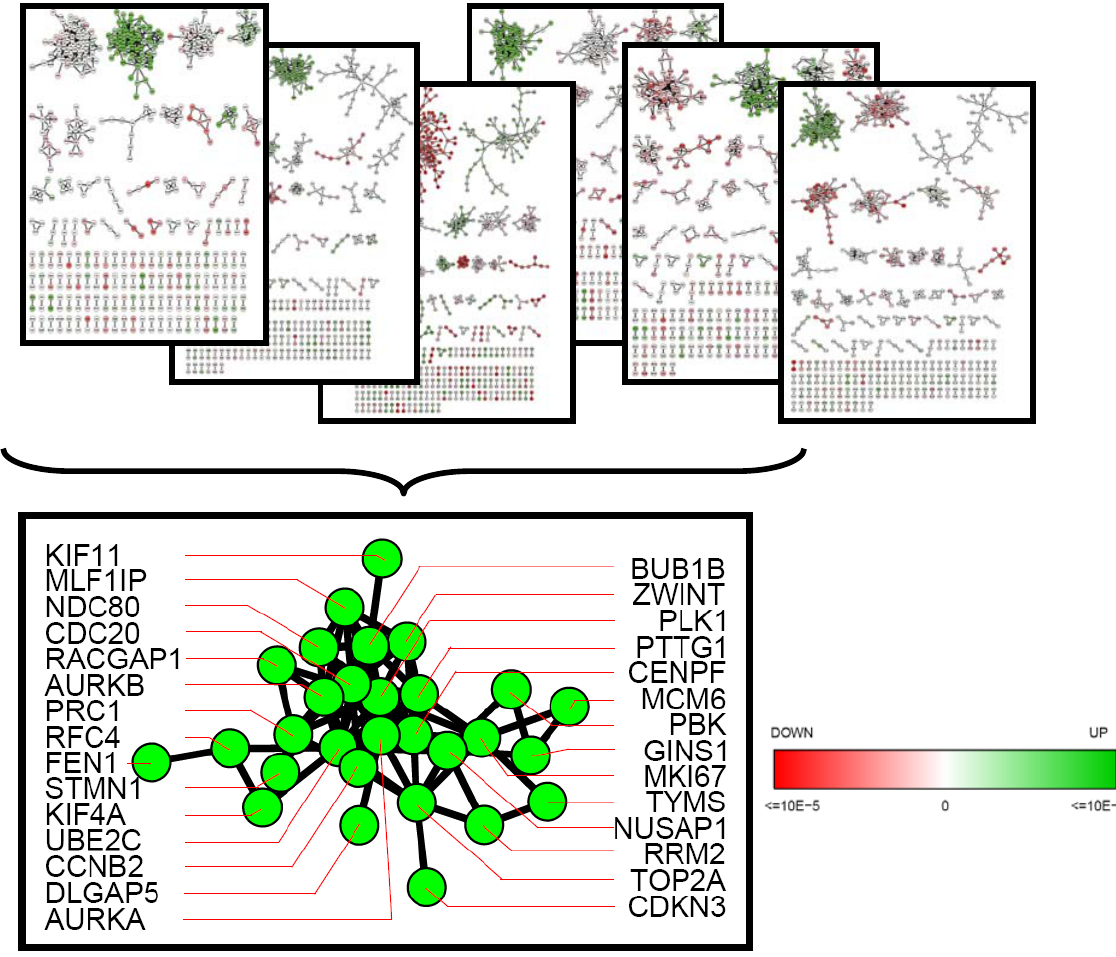
Figure 3: Schematic overview of the construction of a consensus network. Detected sub networks are depicted at the top from left to right for the Desmedt, Muller, Loi, Pawitan, Wang and Schmidt study respectively. A consensus sub network was constructed with genes present in significant sub networks ( α =0.05) in all six studies and is depicted at the bottom. Edges in the consensus sub network are drawn when confidence values of reported PPI interactions exceed